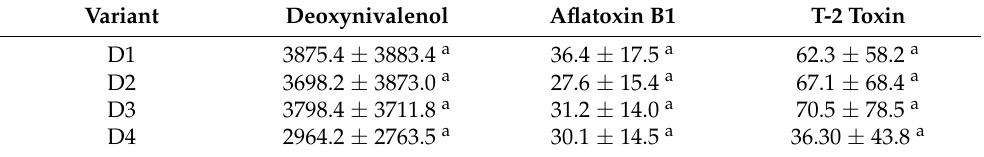
Table 6. Mycotoxin levels ( µ g/kg of dry matter) according to the digestate dose and application.